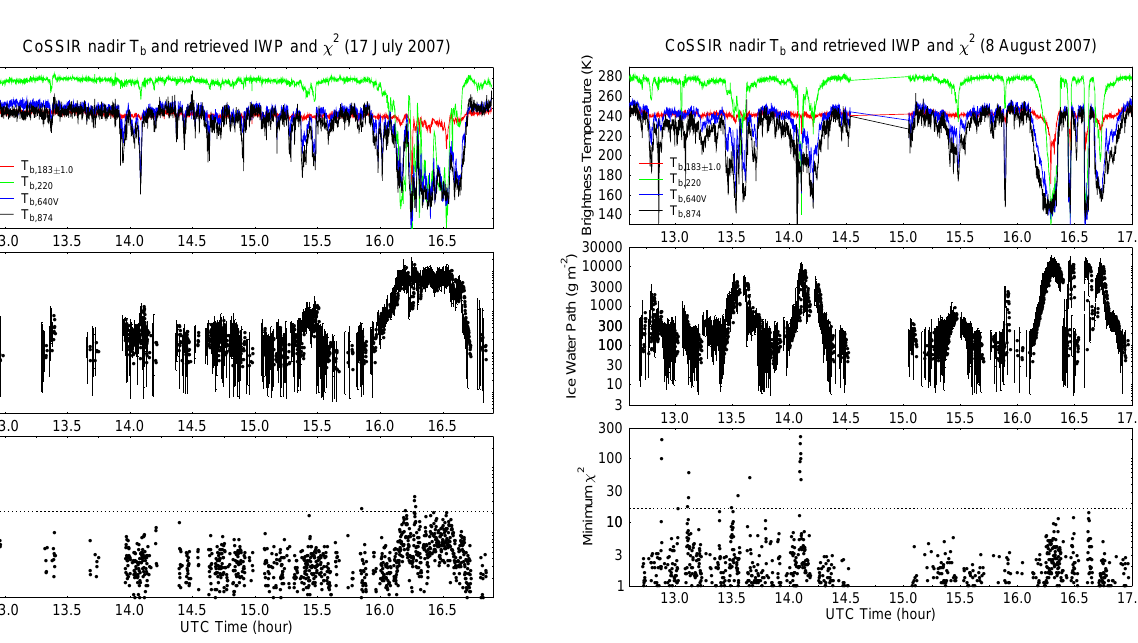
all associated with obvious “noise” on the 874 GHz channel (e.g., spikes at 874 GHz with no change at 640 GHz, though this is difficult to see in Fig. 12 without an expanded time scale).